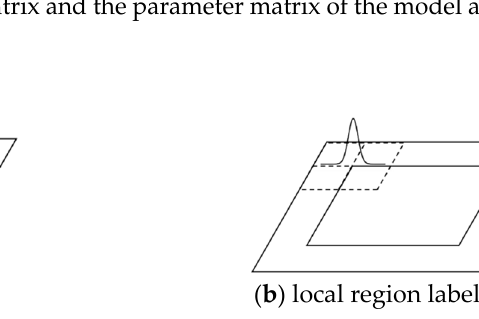
Figure 3. Circular samples based on the local region. The base sample is the target at the center of the image patch shown as the bounding box 1. Box 2 and 3 respectively indicate the circular shifts of the base sample. The arrow in the figure represents the direction of the circular shift.